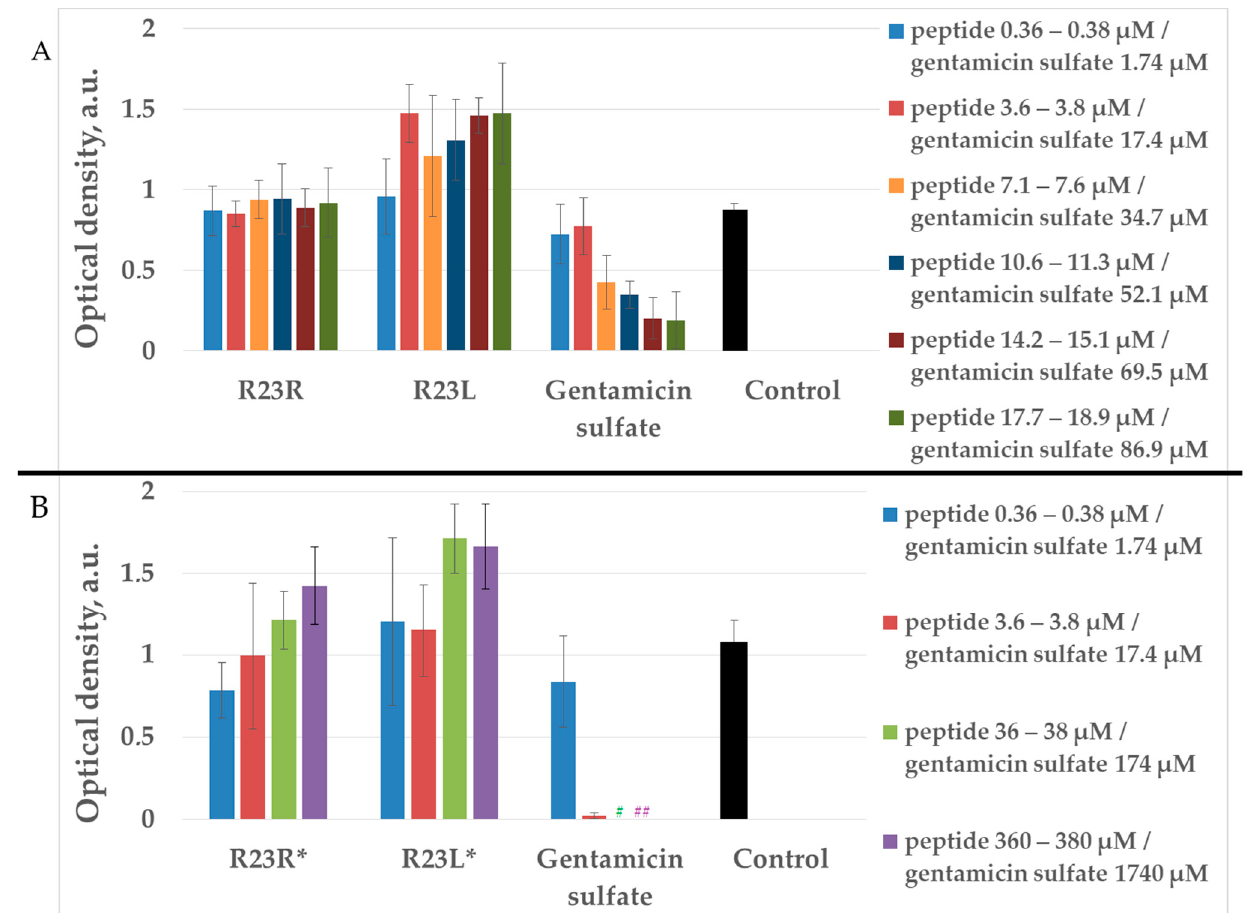
Figure 3. Antibacterial activity of R23R, R23L ( A ) and modified peptides R23R*, R23L* ( B ) after 24 h of co-incubation the peptides with the P. aeruginosa (strain PA103) cells. Various concentrations of gentamicin sulfate were used as positive control for the antimicrobial effect. Control is LB medium containing cell culture in 2% (volume/volume) DMSO without peptide and gentamicin sulfate. Error bars show standard errors. # Optical density is equal to zero for 174 µM concentration of gentamicin sulfate. ## Optical density is equal to zero for 1740 µM concentration of gentamicin sulfate.